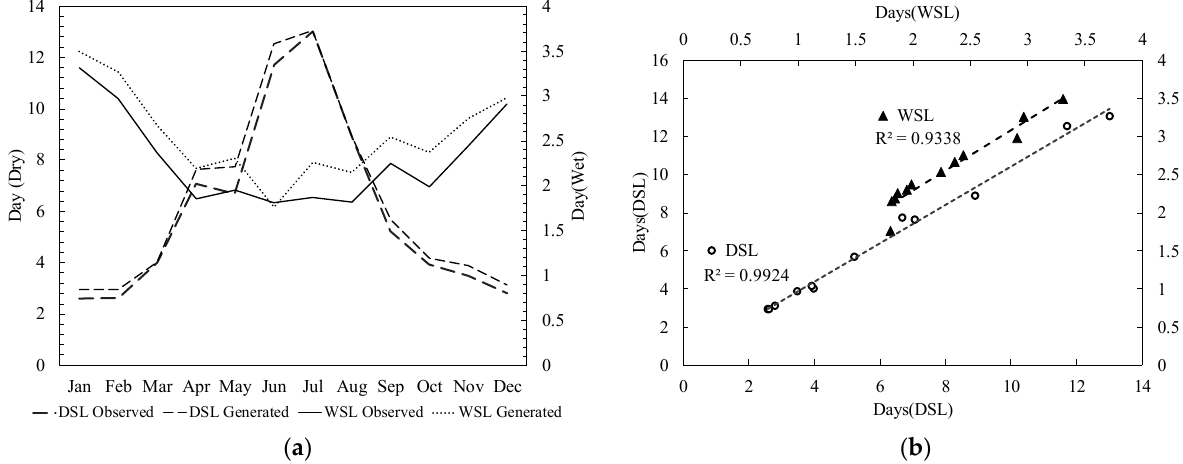
Figure 4. Monthly observed and generated dry and wet spell length (DSL and WSL) ( a ); and correlation of observed and generated DSL and WSL ( b ).